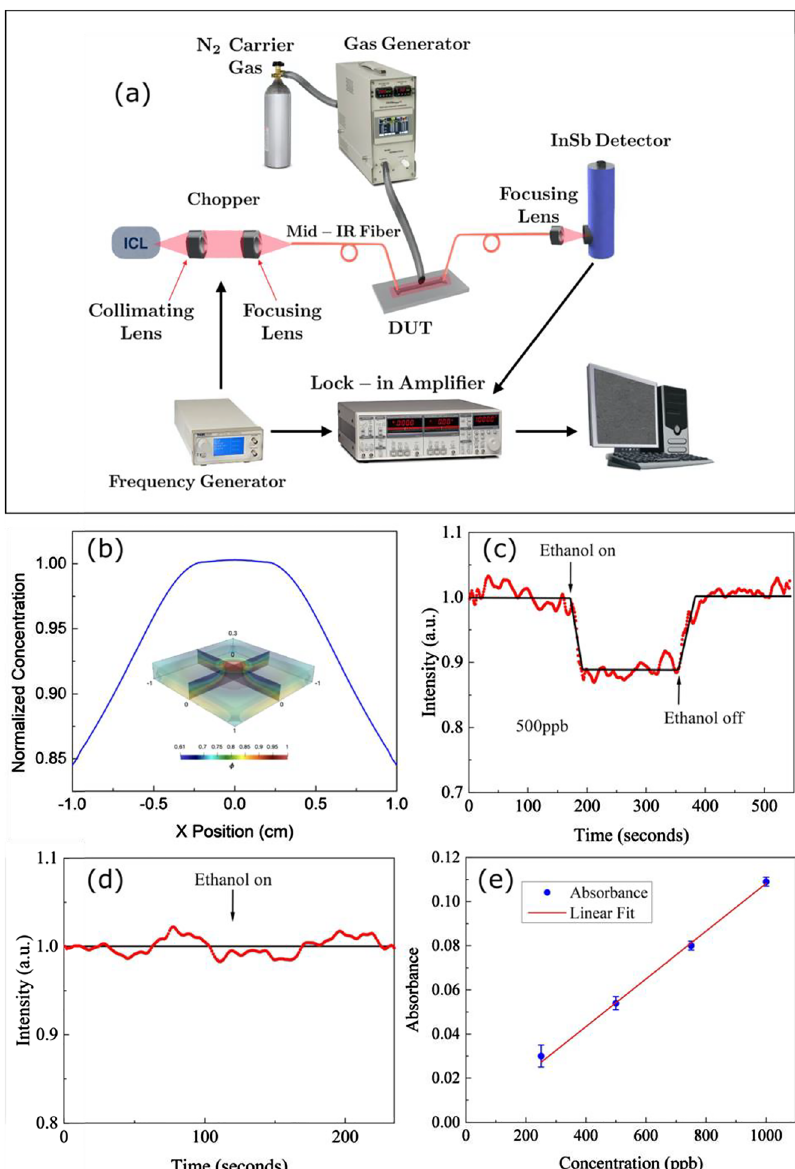
Figure 2: (a) Schematic representation of the measurementsetupforgassensing.(b)Gas concentration along the X axis at y = 0 and z = 0, inset is the steady-state gas concen- tration distribution over the sample normalized to the concentration delivered by the vapor generator. (c) Measured transmitted light intensity through the 9mmlongPCWwhenexposedto500ppbof ethanol vapor. (d) Measured transmitted light intensity through the 1 cm long strip waveguide when exposed to 5 ppm of ethanol vapor. (e) Sensing data for a 9 mm long PCW exposed to different concentra- tions of ethanol, red solid line is the best linear fi t of the